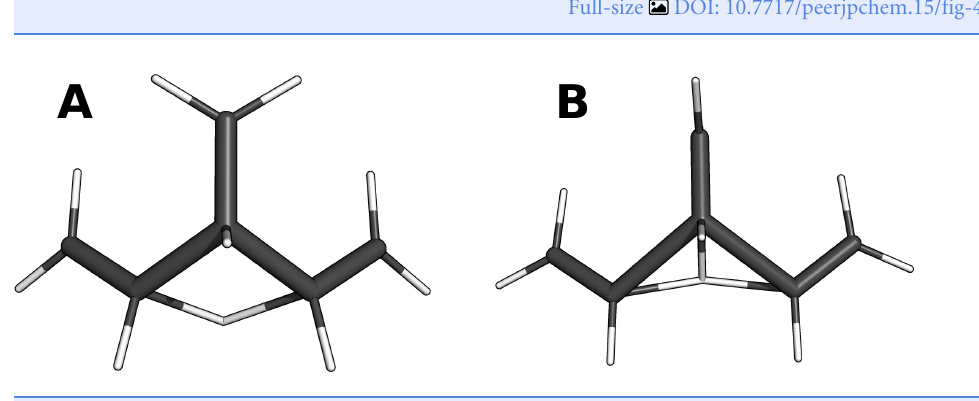
Figure 4 The reaction of the TS located when searching for the TS for reaction 84. Bonds broken in the reaction are indicated in red, bonds formed in blue.